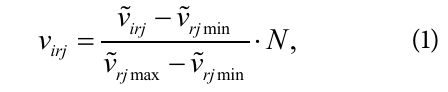
Table 1. Key indicators of sustainable development of industrial regions